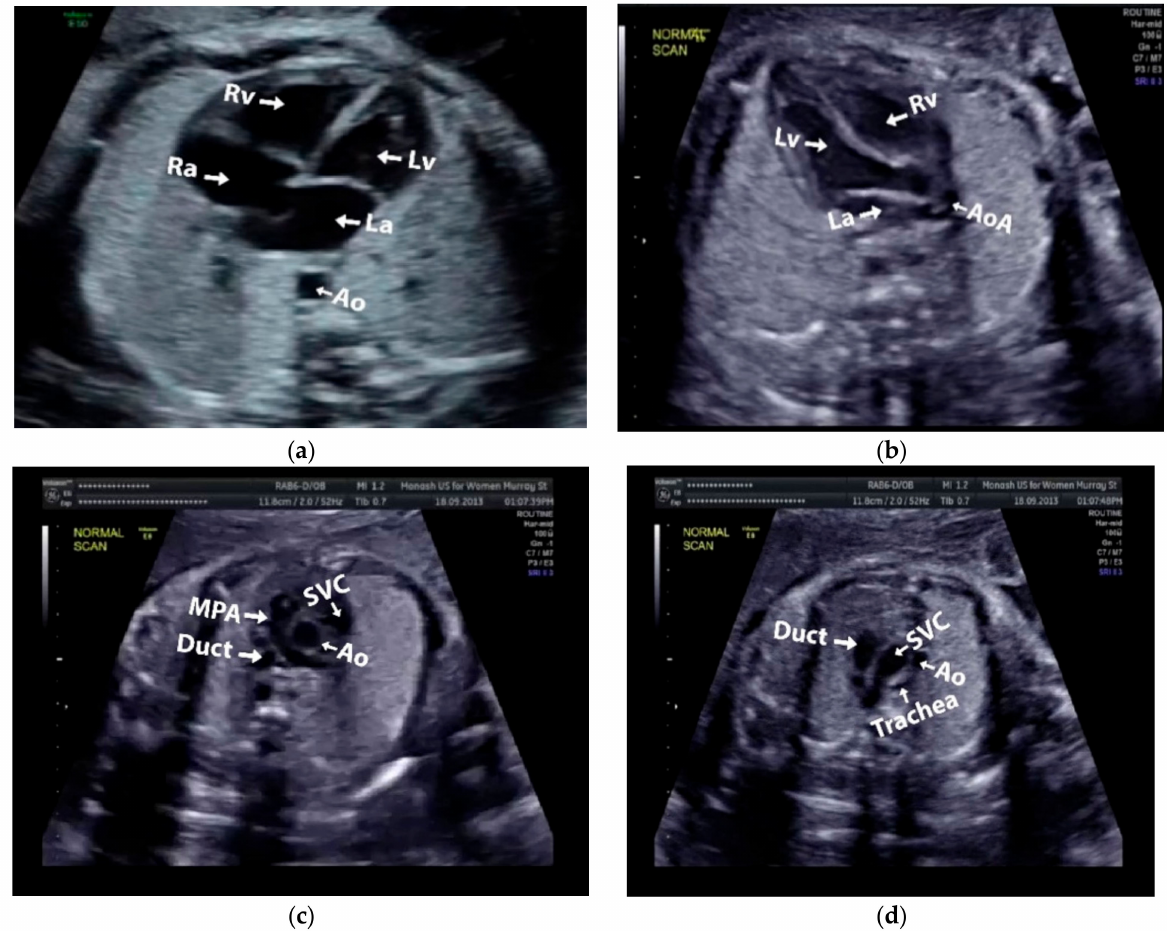
Figure 2. Fetal heart scan in four standard views of normal anatomy: ( a ) 4CH; ( b ) LVOT; ( c ) RVOT; and ( d )